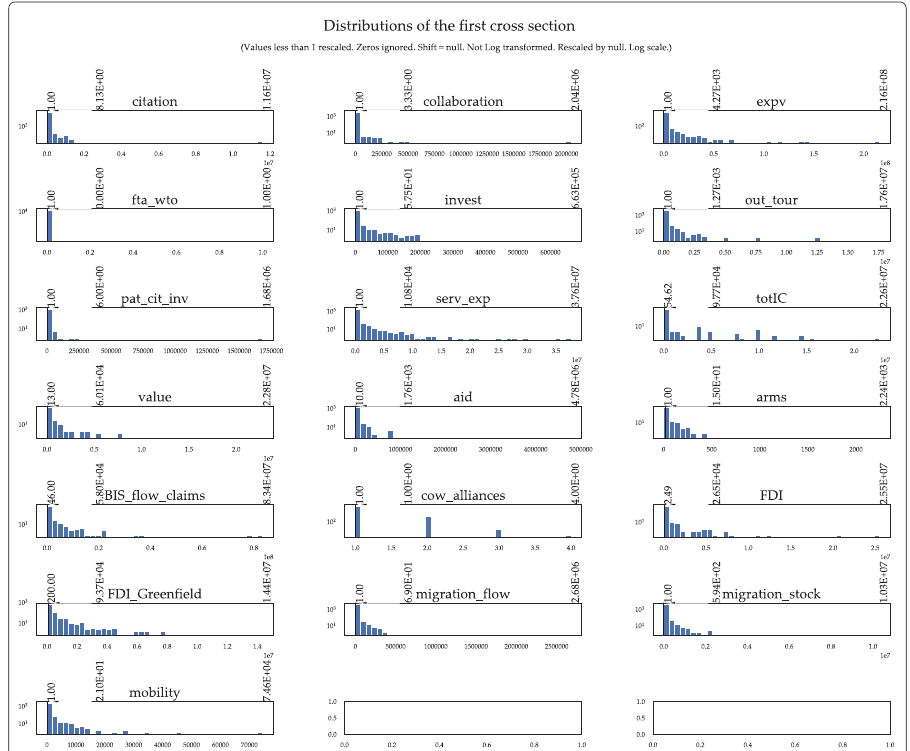
Fig. 13 Positive weights distribution in each layer of the cross section in 2003. Values rescaled to 1 if lower than 1. Logarithmic scale on the y